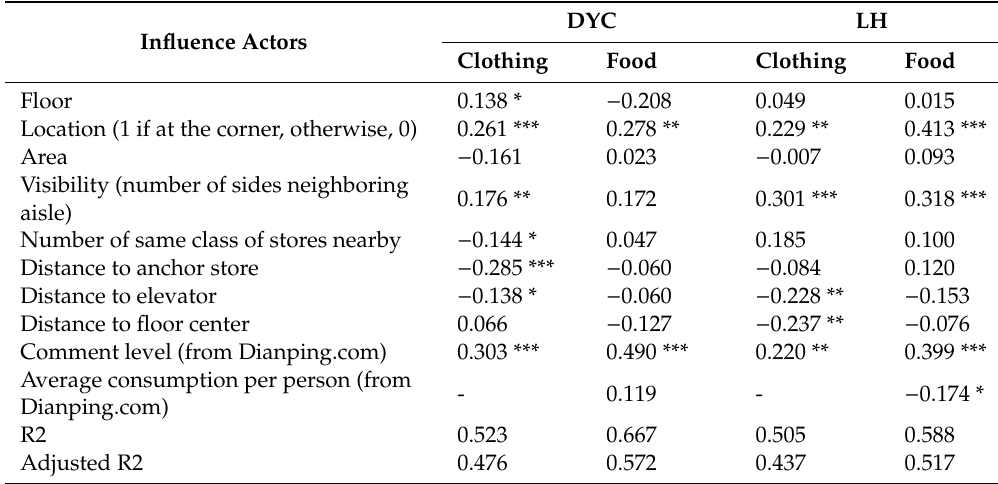
Table 5. Coe ffi cients estimated between store inflow density and its influencing factors.